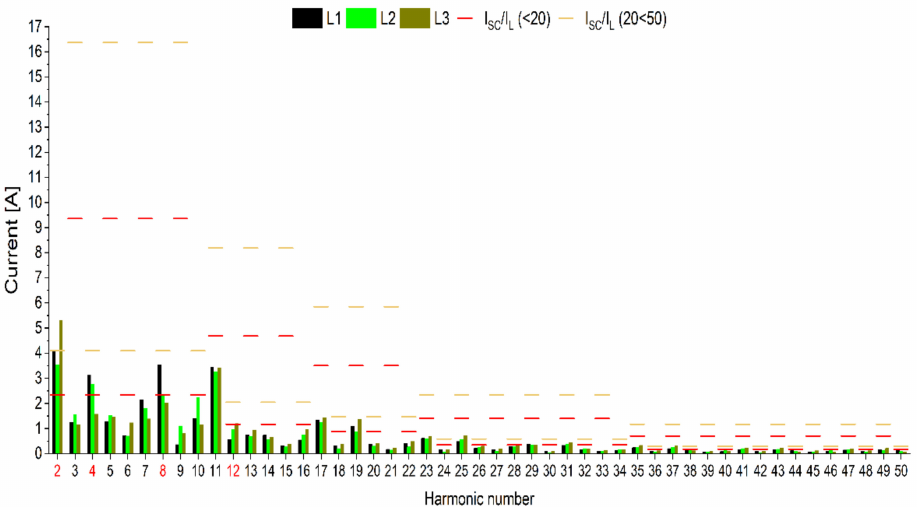
Figure 16. Current harmonic spectrum (99th percentile)—one charging process (I L = 116.93 A).